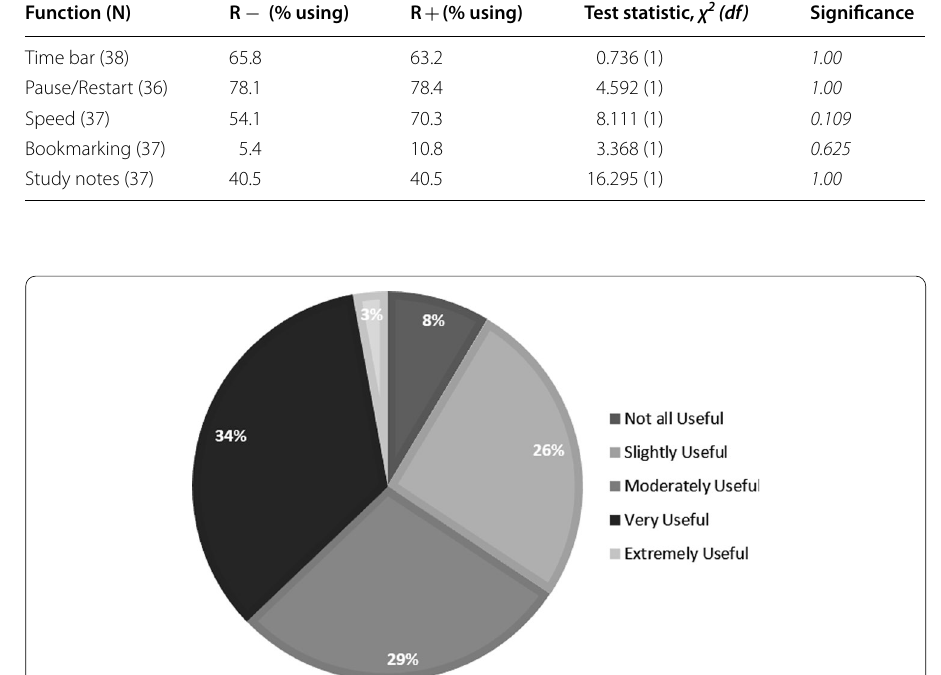
Fig. 3 Percentage of students providing different ratings of usefulness for